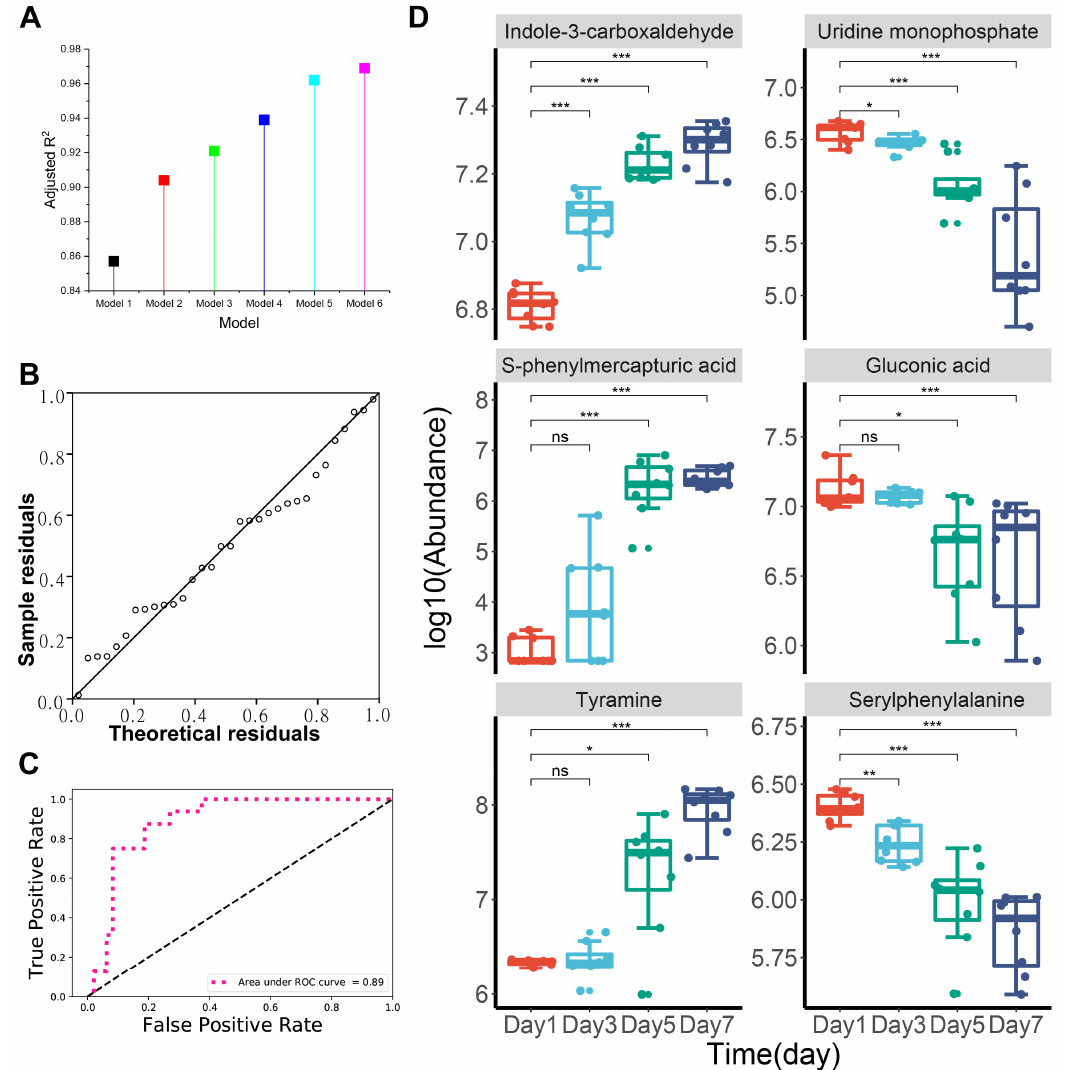
Figure 6. Key metabolic biomarkers selection using stepwise multiple linear regression model. ( A ) Adjusted R 2 of the constructed six models. The adjusted R 2 increased with the increase in the number of variables entered and Model 6 had the highest adjusted R 2 of 0.969; ( B ) Q–Q plots for the residuals obtained from stepwise linear regression models; ( C ) combined ROC curve of the six key metabolic biomarkers. The six biomarkers achieved a combined AUC value of 0.89, indicating the high correlation of the six key biomarkers with the freshness of chilled chicken; ( D ) changes in the relative abundance of the six key biomarkers in chilled chicken during storage over time. A single asterisk indicates p < 0.05, double asterisks indicates p < 0.01, triple asterisks indicates p < 0.001 and ns indicates p > 0.05.